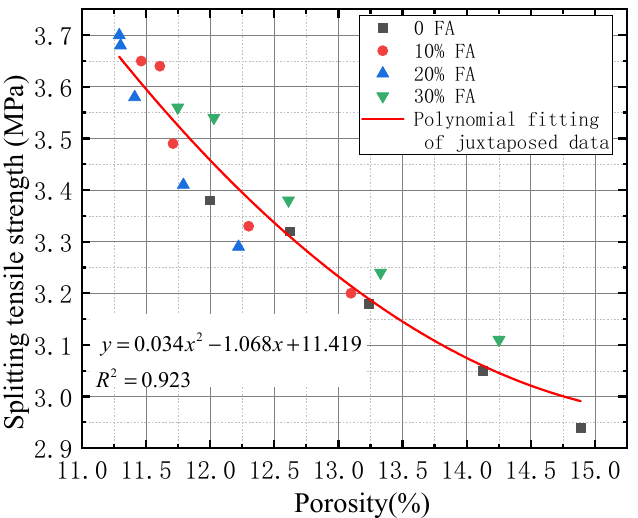
Figure 13. Relationship between splitting tensile strength and porosity.